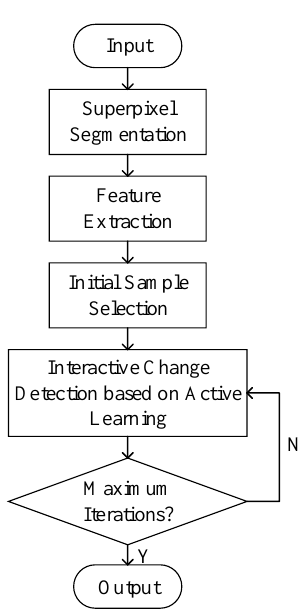
Figure 1. The flow chart of the whole interactive change detection